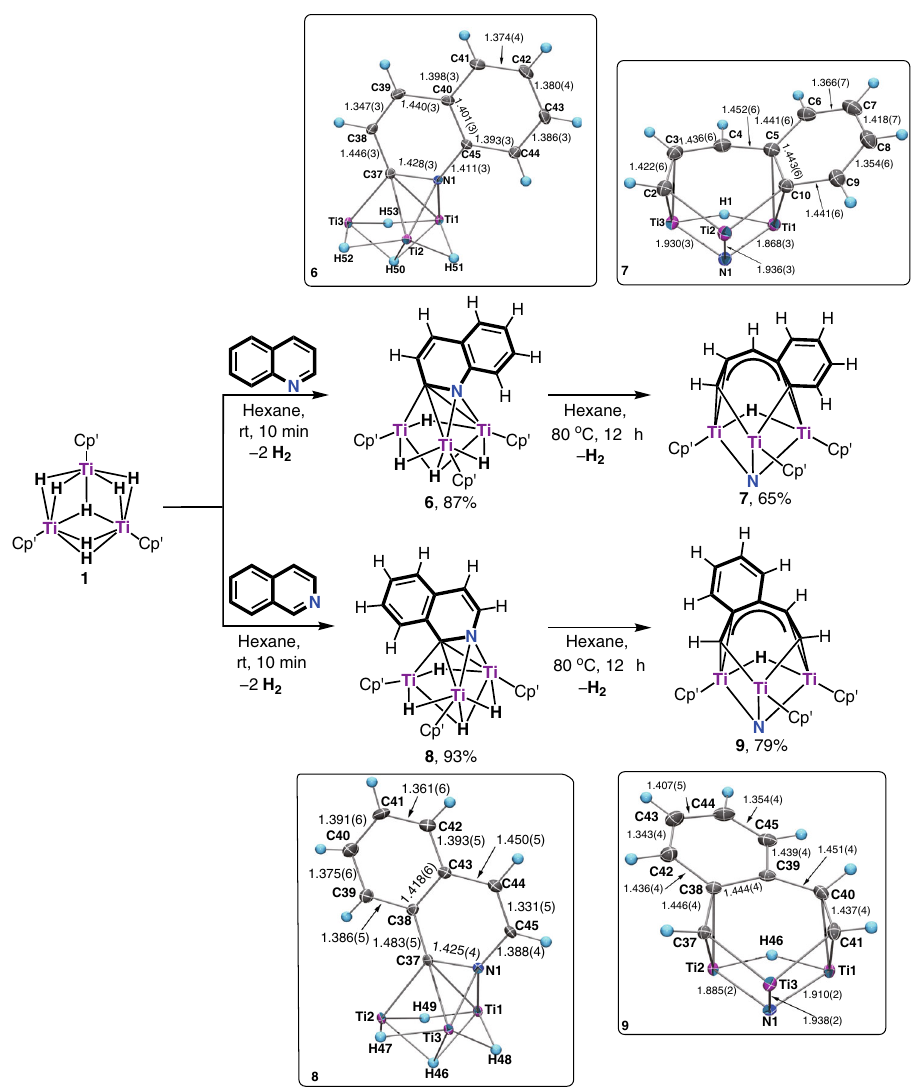
Fig. 3 Hydrodenitrogenation of quinoline and isoquinoline by the titanium hydride complex 1 . Reactions of 1 with quinoline and isoquinoline at room temperature gave 6 and 8 , which upon heating at 80 °C extruded the nitrogen atom from the pyridine unit to give 7 and 9 , respectively. The X-ray structures of 6 , 7 , 8 , and 9 at 30% probability ellipsoids are shown in the square frames, with the C 5 Me 4 SiMe 3 ligands being omitted for clarity. The bond distances of 6 , 7 , 8 , and 9 are given in angstrom